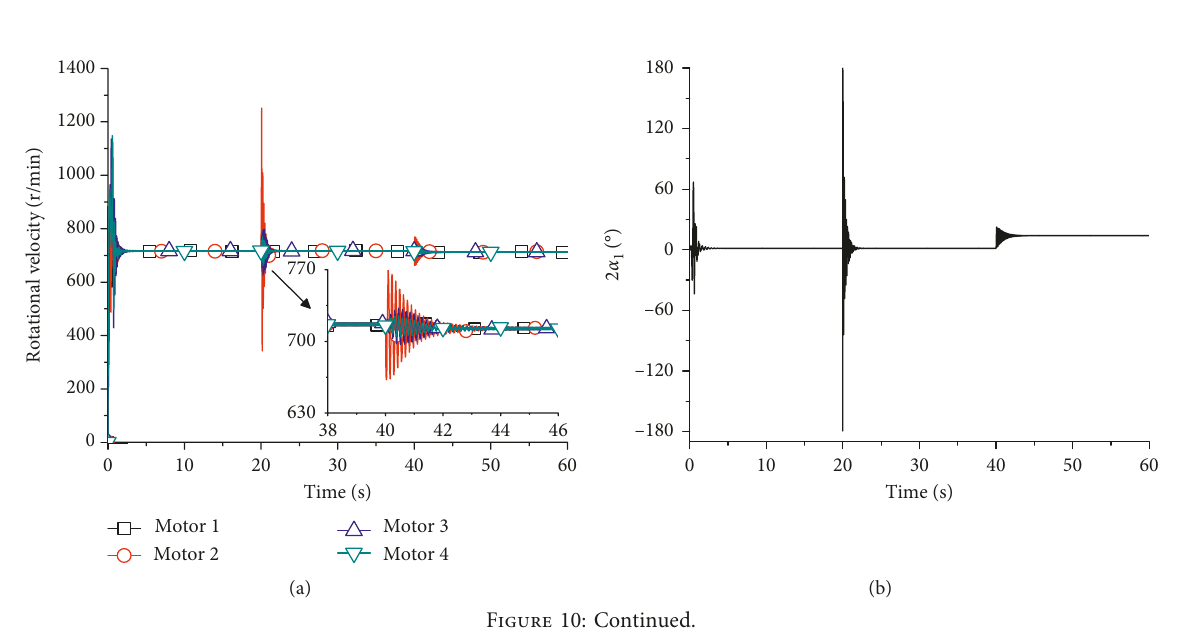
Table 2: The stable phase differences for η Simulation of point A Characteristic